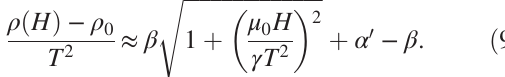
FIG. 6. Magnetoresistance, hot-spot model, and hyperbolic scaling in BaFe 2 ð As 0 showing clear H -linear dependence at high fields. Black lines are fits to the hot-spot MR model given by Eq. (6). Each panel is labeled by the extrapolated zero-temperature resistivity, which quantifies the level of disorder. (b) Hyperbolic scaling of MR for each respective sample. Dashed lines are hyperbolic functions with the parameters shown in each